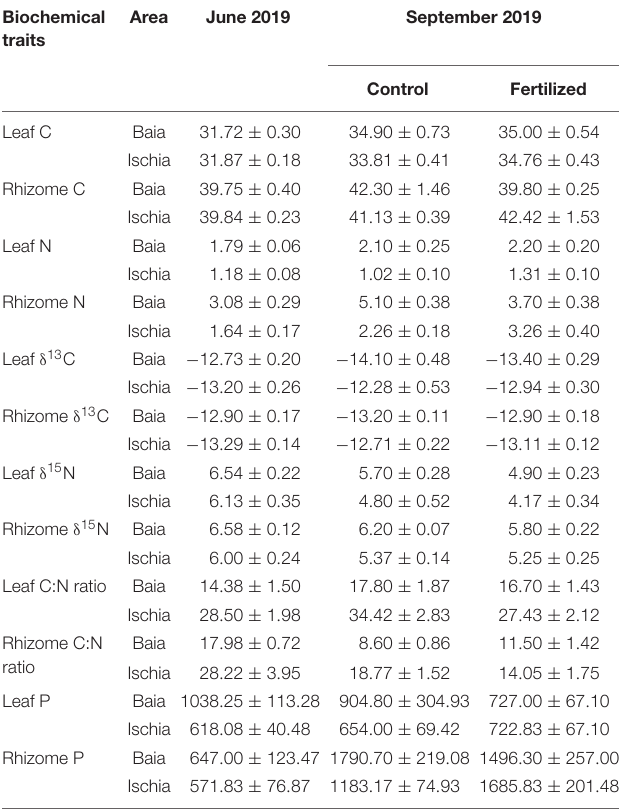
TABLE 2 | Mean ( ± SE) values of nutrient content in leaf and rhizome tissues from P. oceanica meadows ( n = 12) from the anthropogenically impacted sites (Baia- Gulf of Pozzuoli) and low impacted sites (Ischia) in control ( n = 6) and fertilized ( n = 6) plots. Biochemical traits